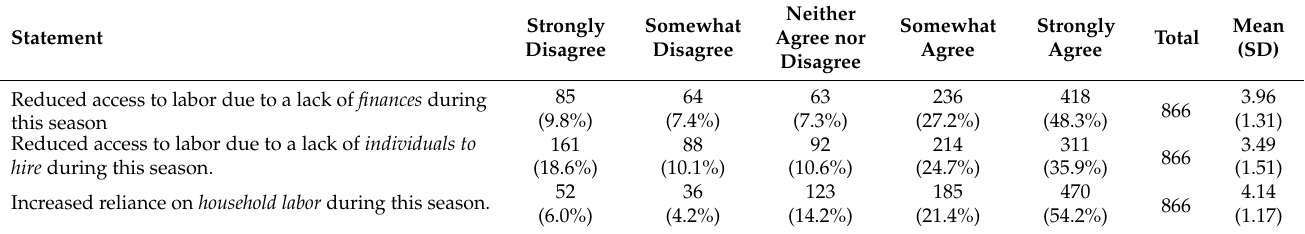
Table 7. Thinking about your experience of what has occurred due to COVID-19, please indicate your agreement or disagreement with the following statements related to access to labor.